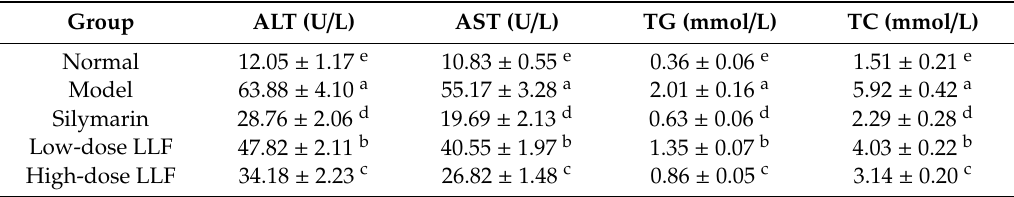
Table 7. Levels of AST, ALT, TG, and TC in mice serum ( n =